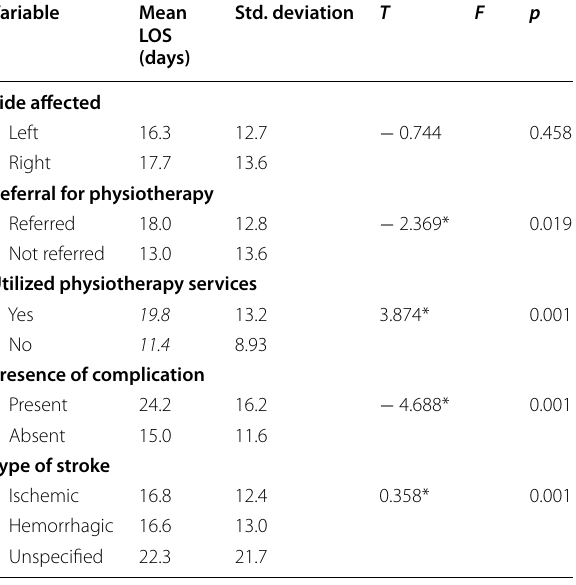
Table 2 Clinical characteristics of stroke patients ( N Variable N 243 =